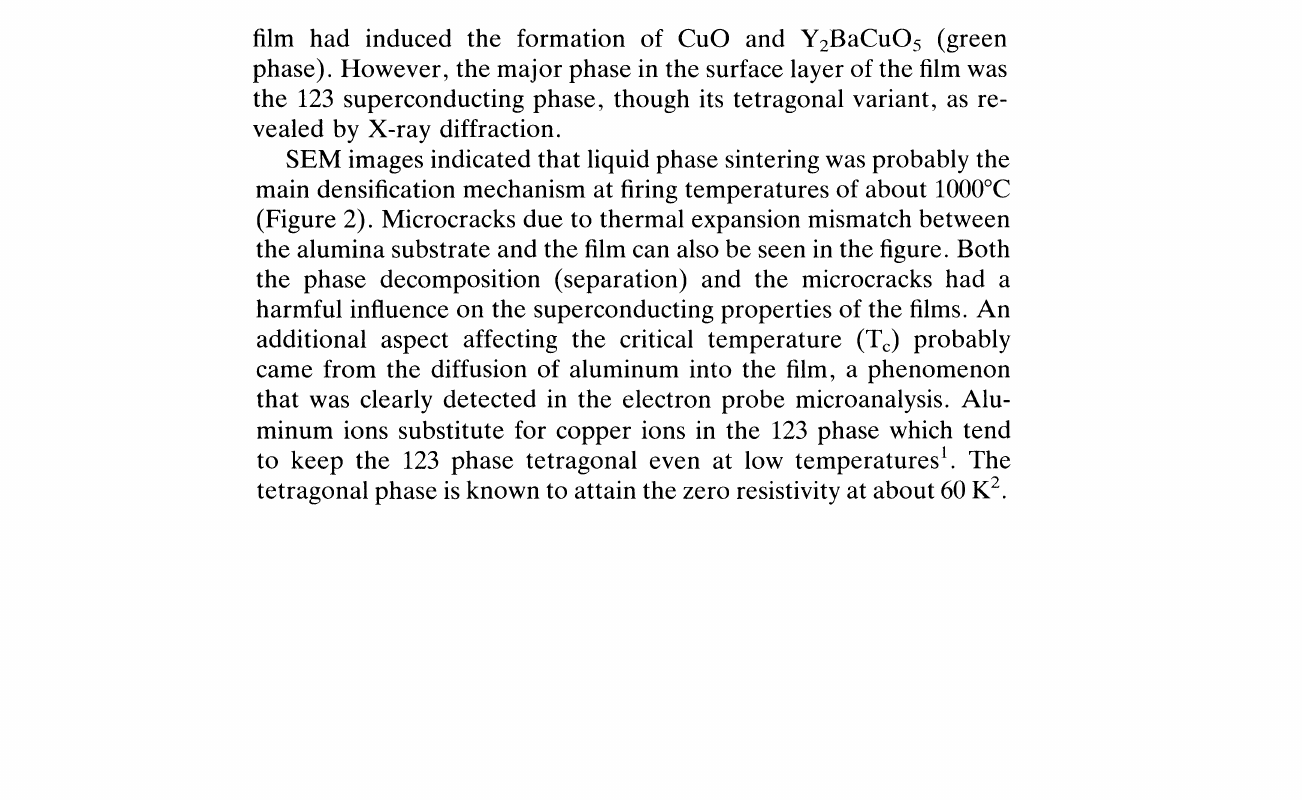
FIGURE Cross-sectional SEM view of a 123 superconducting thick film (A) on a 96% alumina substrate (B). The boundary layer is also visible